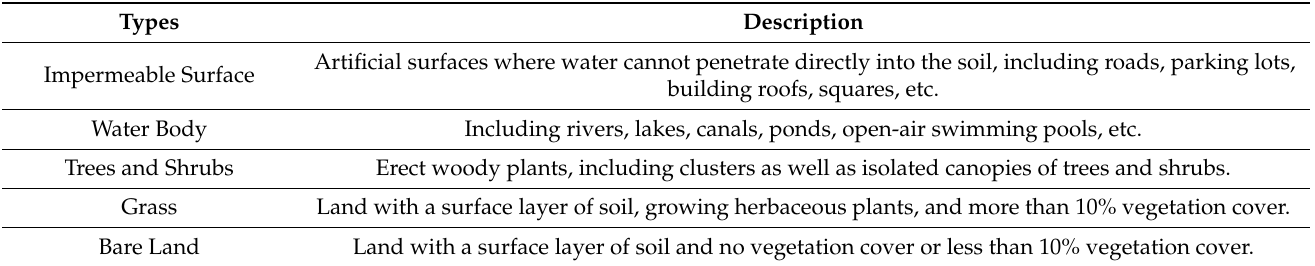
Table 1. Land use classifications.